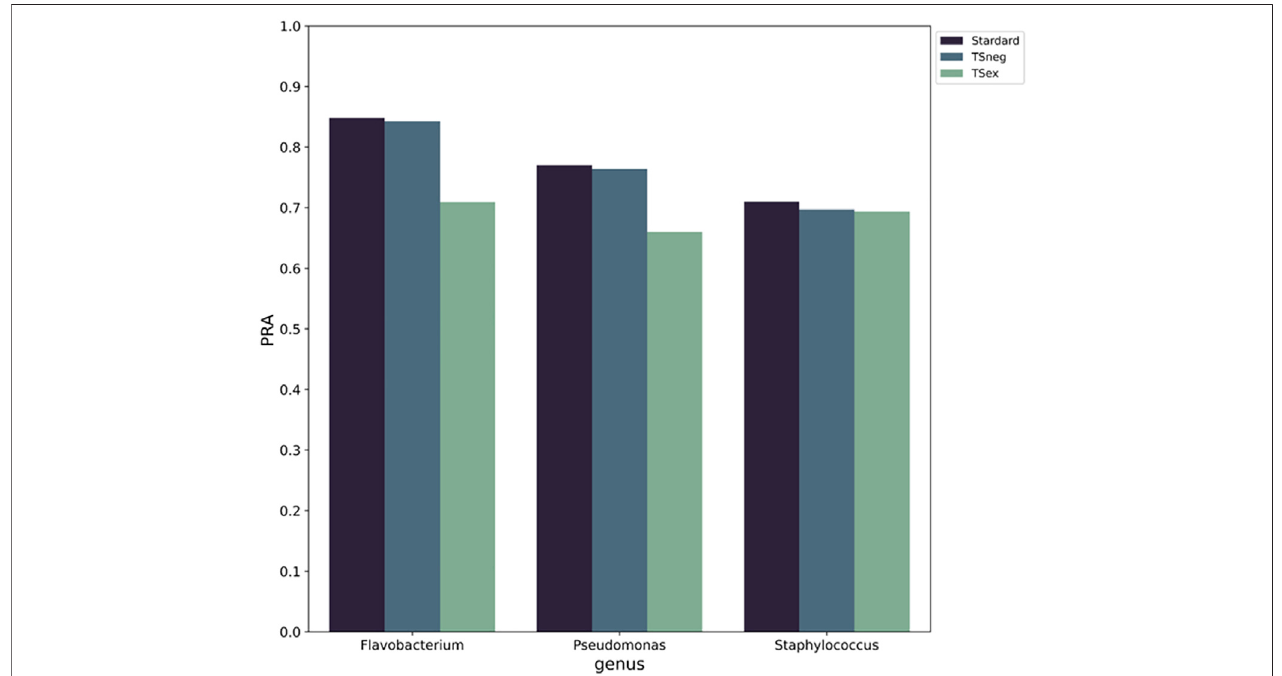
FIGURE 8 | The impact of MGEs on PPA-GCN performance. The horizontal axis represents standard training for the three genera (left), training with the MGEs as negativesamples(middle)andtrainingwiththeMGEsremovedfromthegenesyntenynetwork(right).TheverticalaxisusesPRAasanevaluationindex.Theresultsshow that when the MGE nodes are removed from the networks, the performance of PPA-GCN is signi fi cantly reduced. When they are used as negative samples, the performance of the framework is only slightly